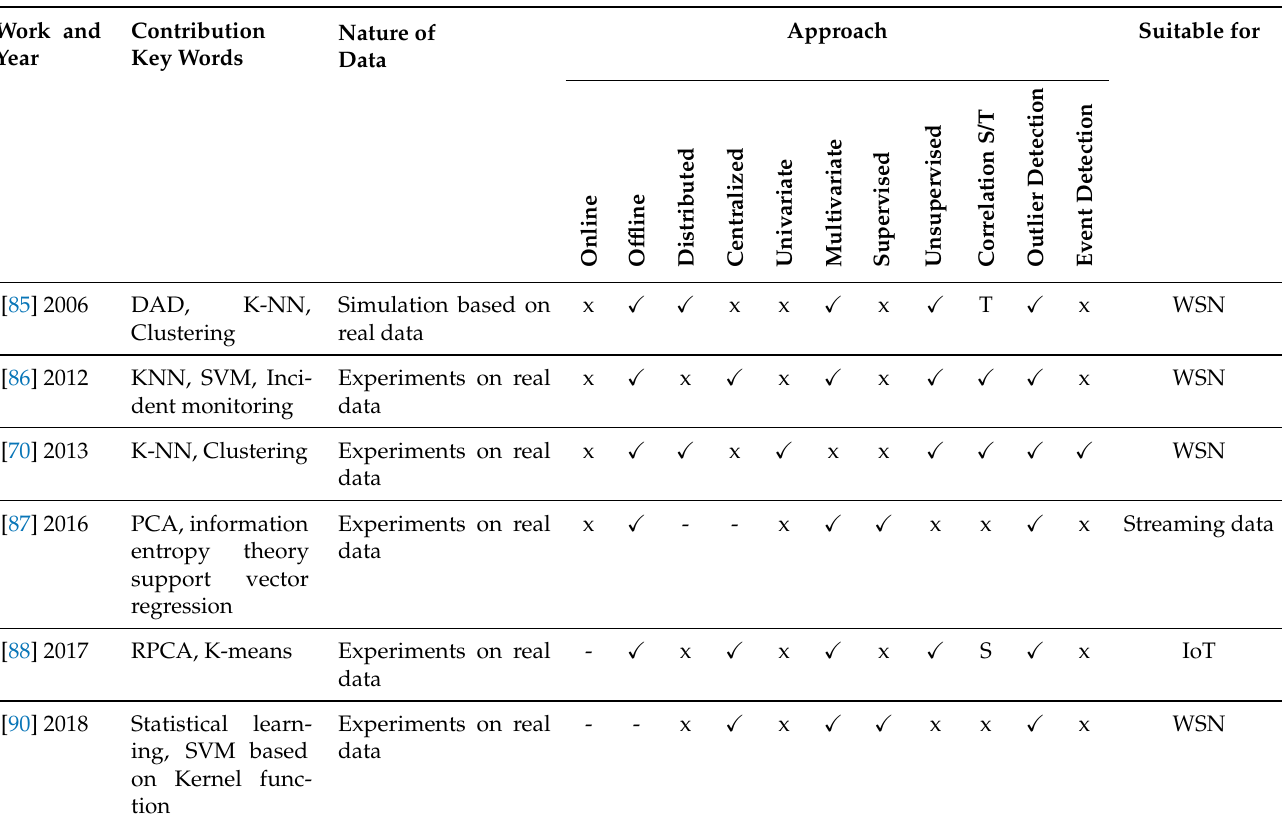
Table 8. Comparative Table of Hybrid-Based